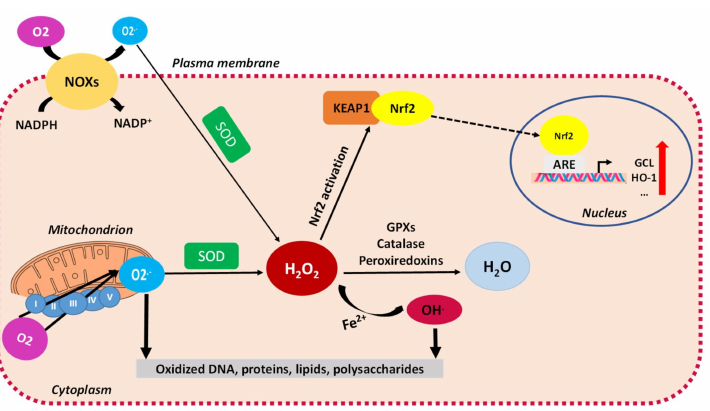
Figure 1. Schematic representation of ROS generation and enzymatic antioxidant defenses. Su- peroxide anion (O 2 − . ) is mainly produced by NADPH oxidases (NOXs) and by the mitochondrial ETC complexes by partial reduction of molecular oxygen (O 2 ). Superoxide is dismutated into hy- drogen peroxide (H 2 O 2 ) by superoxide dismutases (SODs). H 2 O 2 is converted to water (H 2 O) by glutathione peroxidases (GPX), peroxiredoxins (PRX), or catalase. Via the Fenton reaction with metal ions Fe 2+ or Cu + , H 2 O 2 is further reduced to highly reactive hydroxyl radical (OH . ), thereby damaging biological macromolecules such as DNA, lipids, and proteins. H 2 O 2 is the main player in redox homeostasis, and can induce the activation of Nrf2 through dissociation of the Nrf2-KEAP1 complex, phosphorylation of Nrf2, and its nuclear translocation. In the nucleus, Nrf2 promotes transcription of antioxidant genes by binding to the ARE in the promoter region. Abbreviations: ARE, antioxidant response element; ETC, electron transport chain; GPXs, glutathione peroxidases; H 2 O 2 , hydrogen peroxide; HO-1, heme oxygenase-1; KEAP1, Kelch-like ECH-associated protein 1; NADPH, nicotinamide adenine dinucleotide phosphate hydrogen; NADP+, nicotinamide adenine dinucleotide phosphate; NOXs, NADPH oxidases; Nrf2, nuclear factor erythroid 2-related factor 2; O 2 , dioxygen; O 2 − , superoxide anion; OH, hydroxyl radical; SOD, superoxide dismutase; TXN,